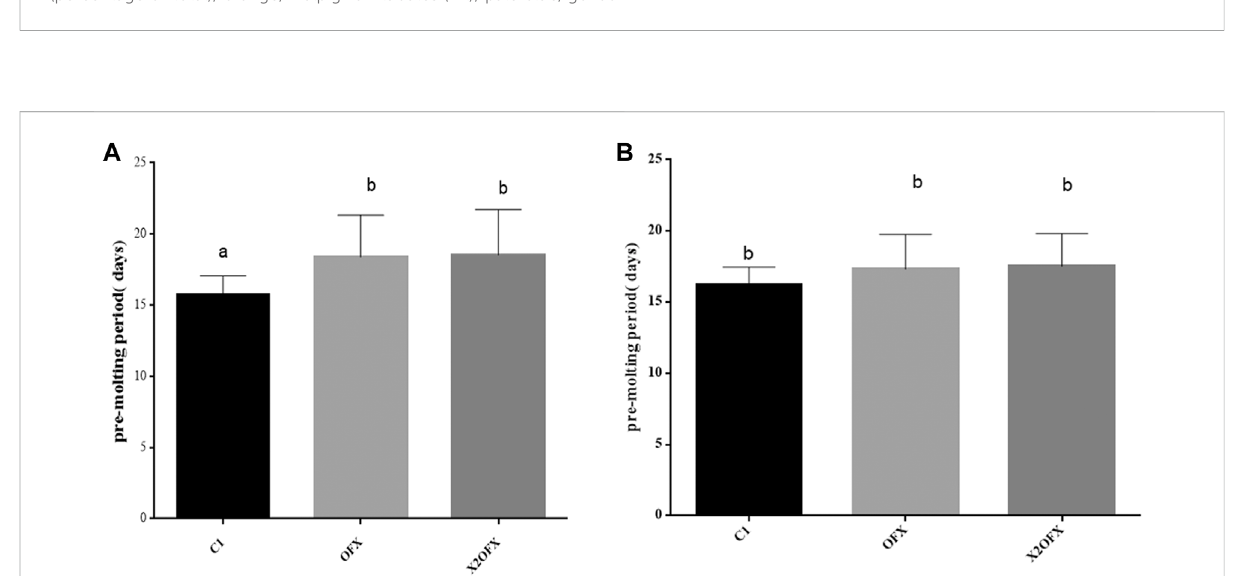
FIGURE 5 Pre-molt development time of female and male nymphs. Pre-molt development time of female (A) and male (B) nymphs, when injected with saline (C1), o fl oxacin-containing saline at a dose of 30 ng/mg tick body weight (OFX) or 60 ng/mg body weight (X2OFX). For male and female nymphs, n = 15 per group. Different letters indicate signi fi cant differences ( p ≤